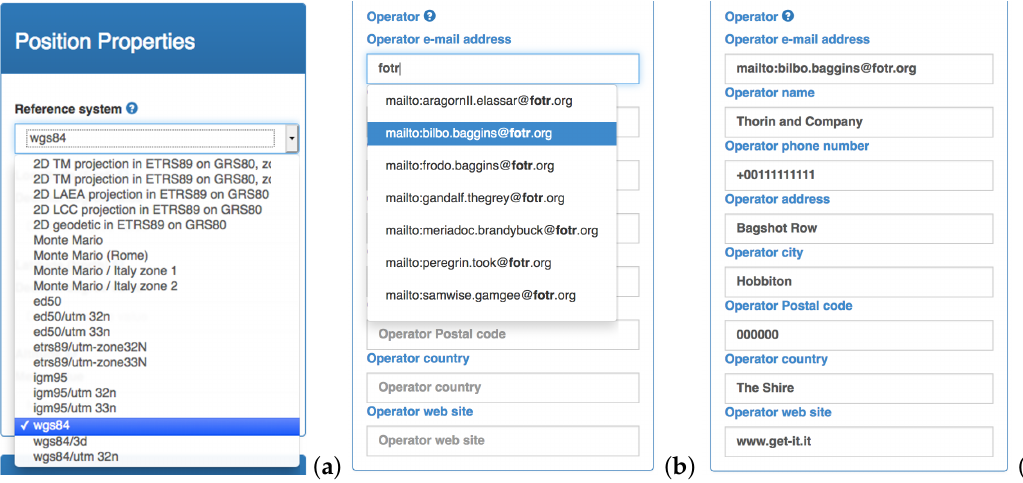
Figure 5. Items connected to datasources of type: codelist ( a ); sparql ( b ); and singleton ( c